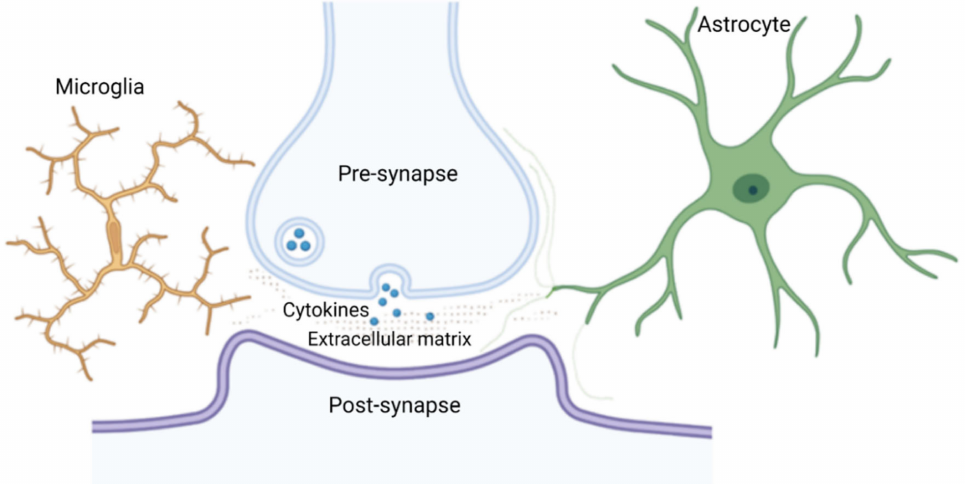
Figure 2. Schematic illustration of the penta-partite synapse consisting of the pre- and post-synaptic neuronal membranes, astrocyte processes (green), extracellular matrix components (dots) and a microglial process (orange) that may be transiently